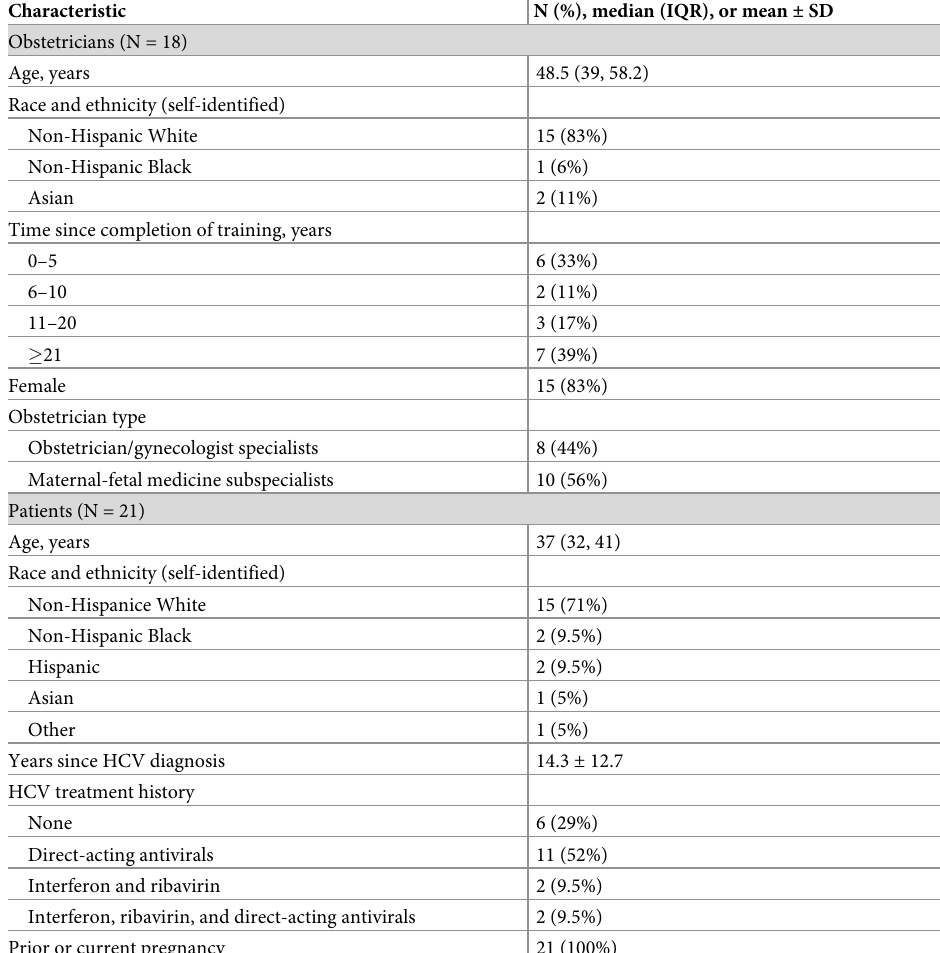
Table 1. Obstetrician and patient participant